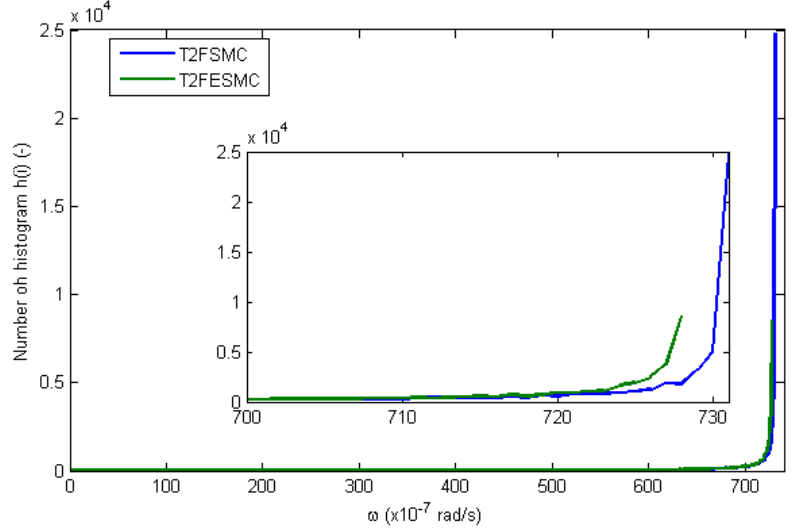
Fig. 6: The number of histograms h(i) in the conversion range [0.73x10 ‐5 ] with stepsize 1x10 ‐7